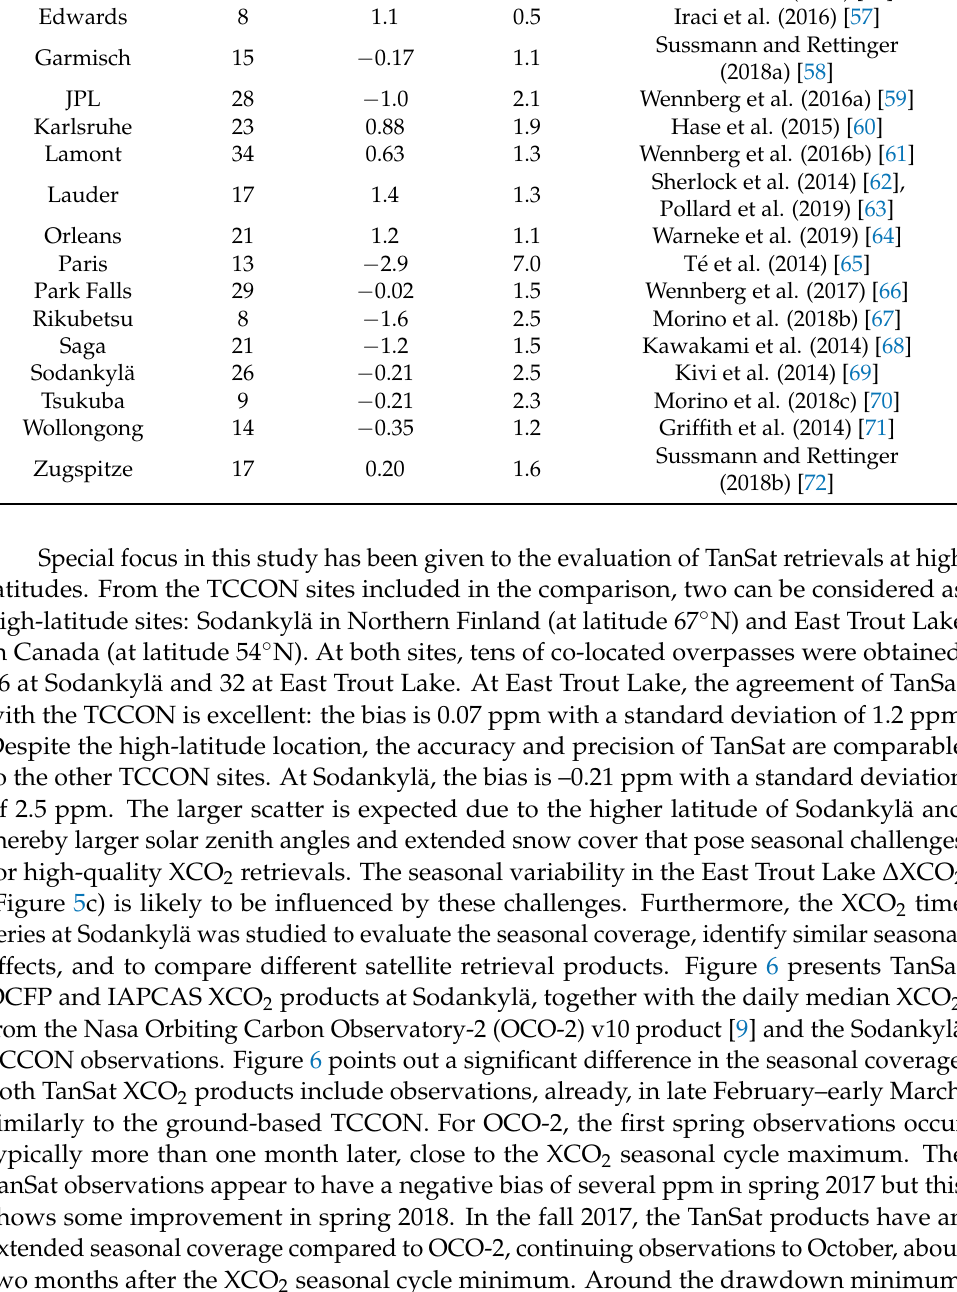
TCCON observations. Figure 6 points out a significant difference in the seasonal coverage: both TanSat XCO 2 products include observations, already, in late February–early March, similarly to the ground-based TCCON. For OCO-2, the first spring observations occur typically more than one month later, close to the XCO 2 seasonal cycle maximum. The TanSat observations appear to have a negative bias of several ppm in spring 2017 but this shows some improvement in spring 2018. In the fall 2017, the TanSat products have an extended seasonal coverage compared to OCO-2, continuing observations to October, about two months after the XCO 2 seasonal cycle minimum. Around the drawdown minimum, TanSat observations have positive bias compared to the TCCON. This result is different with TCCON validation shown in previous studies [41] which has used measurement orbits with more than 50 datapoints to reduce the scattering effect comes from few